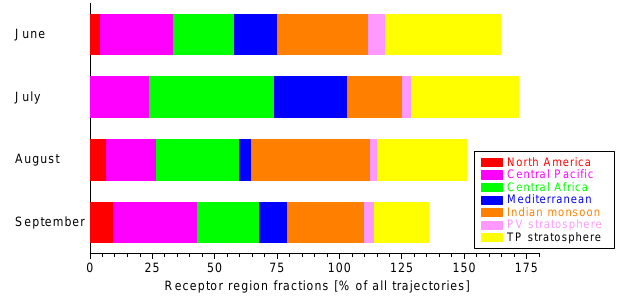
Figure 13. Receptor region fractions averaged over all CARIBIC Figure12. ReceptorregionfractionsaveragedoverallCARIBICflightstoChennaiinJunetoSeptember2008. flights to Chennai in June to September 2008. Since trajectories may Since trajectories may reach multiple receptor regions, the totals exceed 100 % . reach multiple receptor regions, the totals exceed